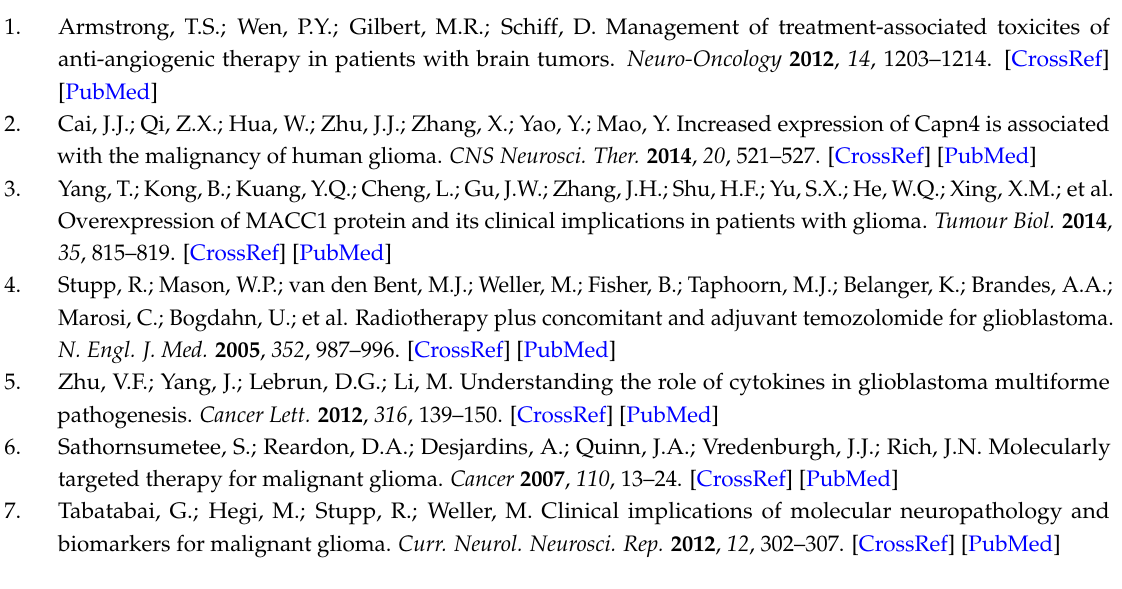
Figure S1: Overexpression of RACK1 in glioma tissues was examined by Western-blot in 10 cases of normal brain tissues, 50 cases of low grade (I–II grade) and 30 cases of high grade (III–IV grade) malignancy of glioma tissues. Acknowledgments: This study was supported by The National Natural Science Foundation of China (No.